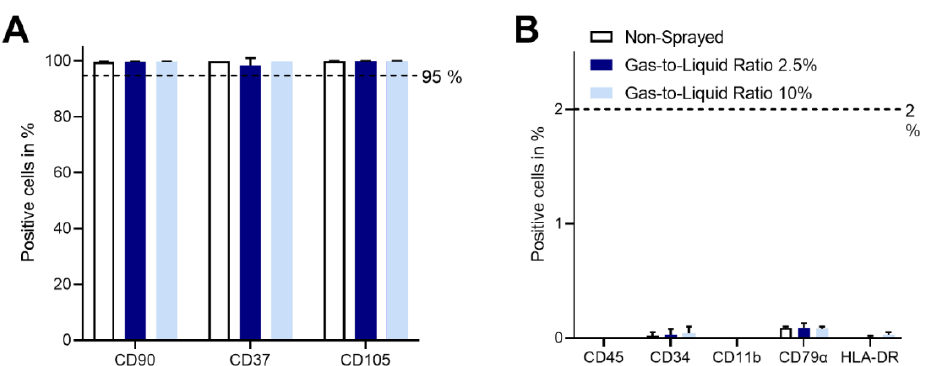
Figure 8. Percentage of positive ASCs ( n = 3) cells stained for eight mesenchymal stromal cell- characteristic markers of non-sprayed and sprayed with gas-to-liquid ratio 2.5% and 10% after 7 days of culture. Flow cytometric analysis shows that all experimental conditions fulfill the minimal criterion defined by Dominici et al. [18] regarding the surface marker expression; CD90, CD37, and CD105 are expressed in more than 95% ( A ), CD45, CD34, CD11b, CD79 α , and HLA-DR in less than 2% of cells ( B ).